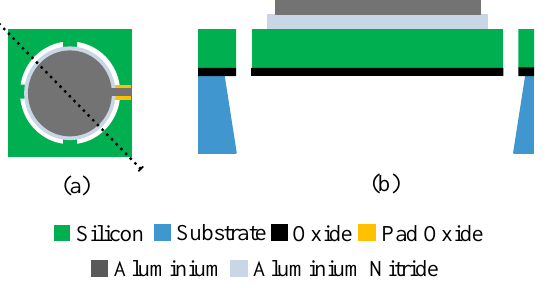
Figure 2. ( a ) Top view and ( b ) Cross Section of PMUT fabricated using the PiezoMUMPS technology.